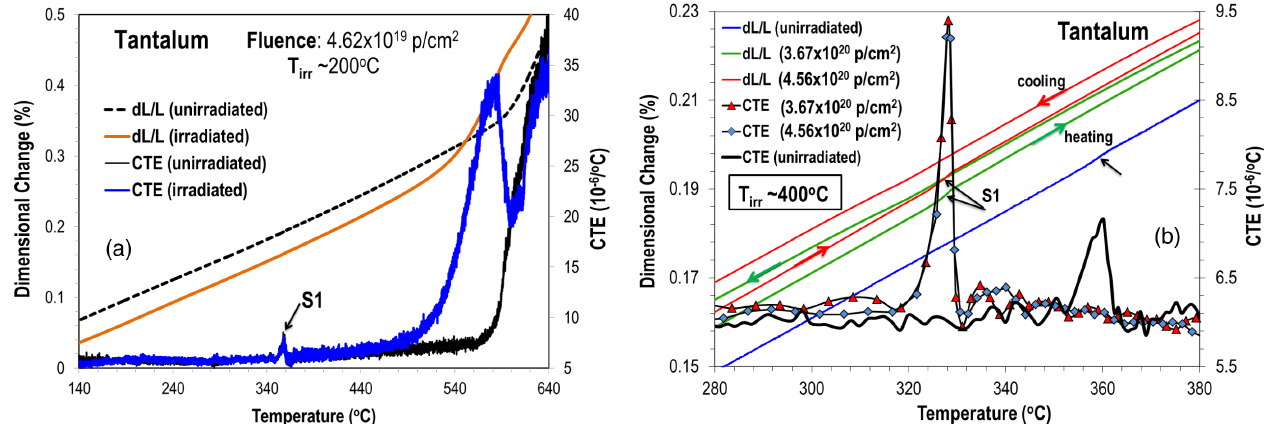
FIG. 26. (a) Proton irradiation effect on the dimensional stability and oxidation of tantalum irradiated at 200 °C, and (b) dimensional change and CTE of tantalum as a function of proton fluence.